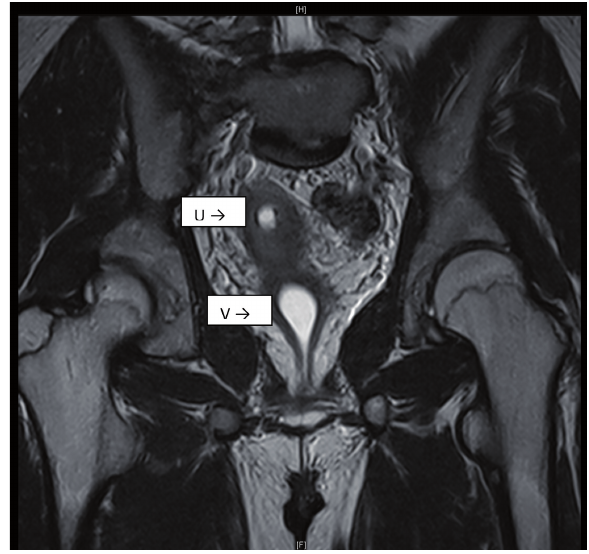
figure 2 - MRI of the pelvis, showing the uterus (u) and the hydrocolpos